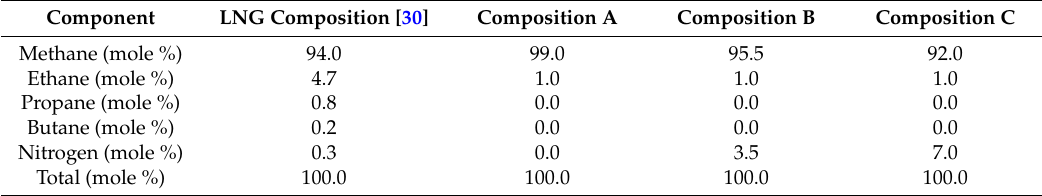
Table 2. LNG and Boil-off gas (BOG) composition cases with different nitrogen contents.